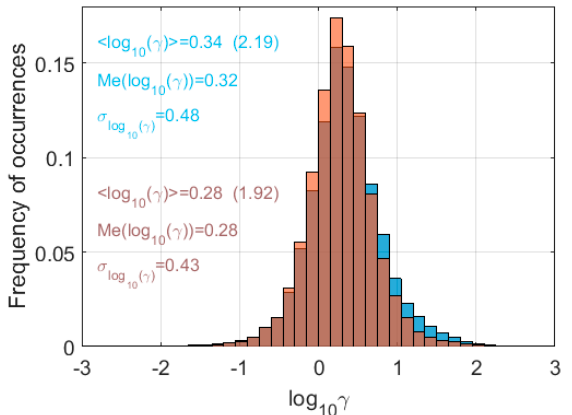
Figure 7. Histograms of log 10 ( γ ) for data collected during ShUREX 2016 and ShUREX 2017 without convective boundary layers (CBL), mid-level cloud base (MCT) and clouds (brown) and with all data (cyan). The symbol < > refers to the mean value, “Me” to the median value and 𝜎 to the standard deviation